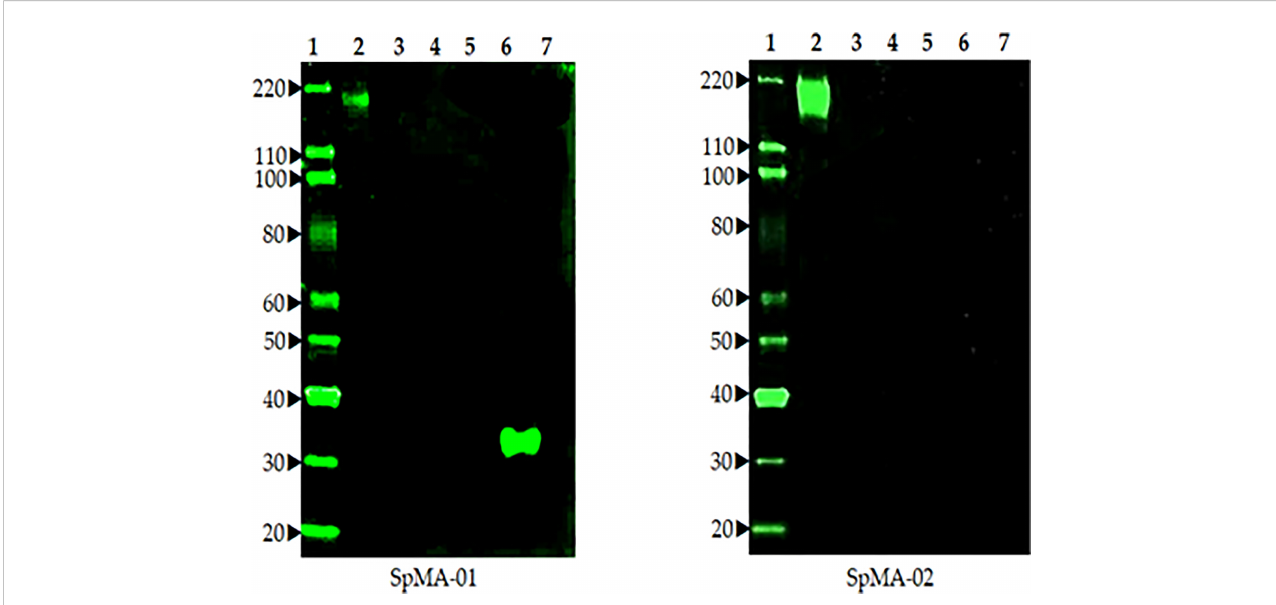
FIGURE 3 The Western blot analysis of two anti-spike mAbs (SpMA-01 and SpMA-02) with coronavirus proteins. Lane 1. Magic marker, Lane 2. NR-52397 SARS- CoV-2 full-length recombinant Spike protein, Lane 3. NR 53713 Spike protein human Coronavirus HKU1, Lane 4. NR-53591 MERS coronavirus, Lane 5,